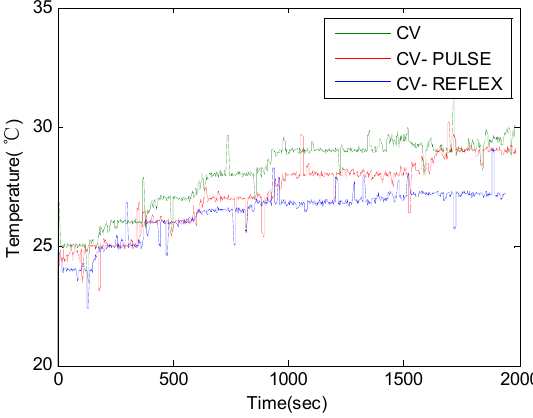
Figure 8. Temperature rise curve comparison diagram.